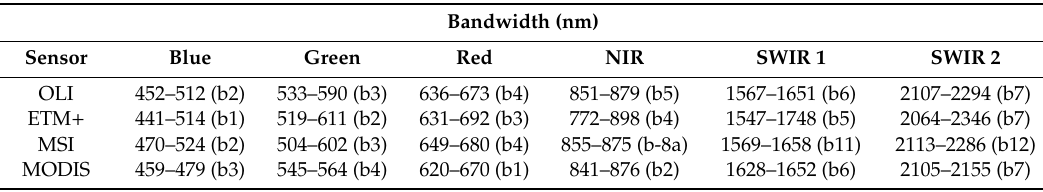
Table 2. Sensor Spectral Bands.